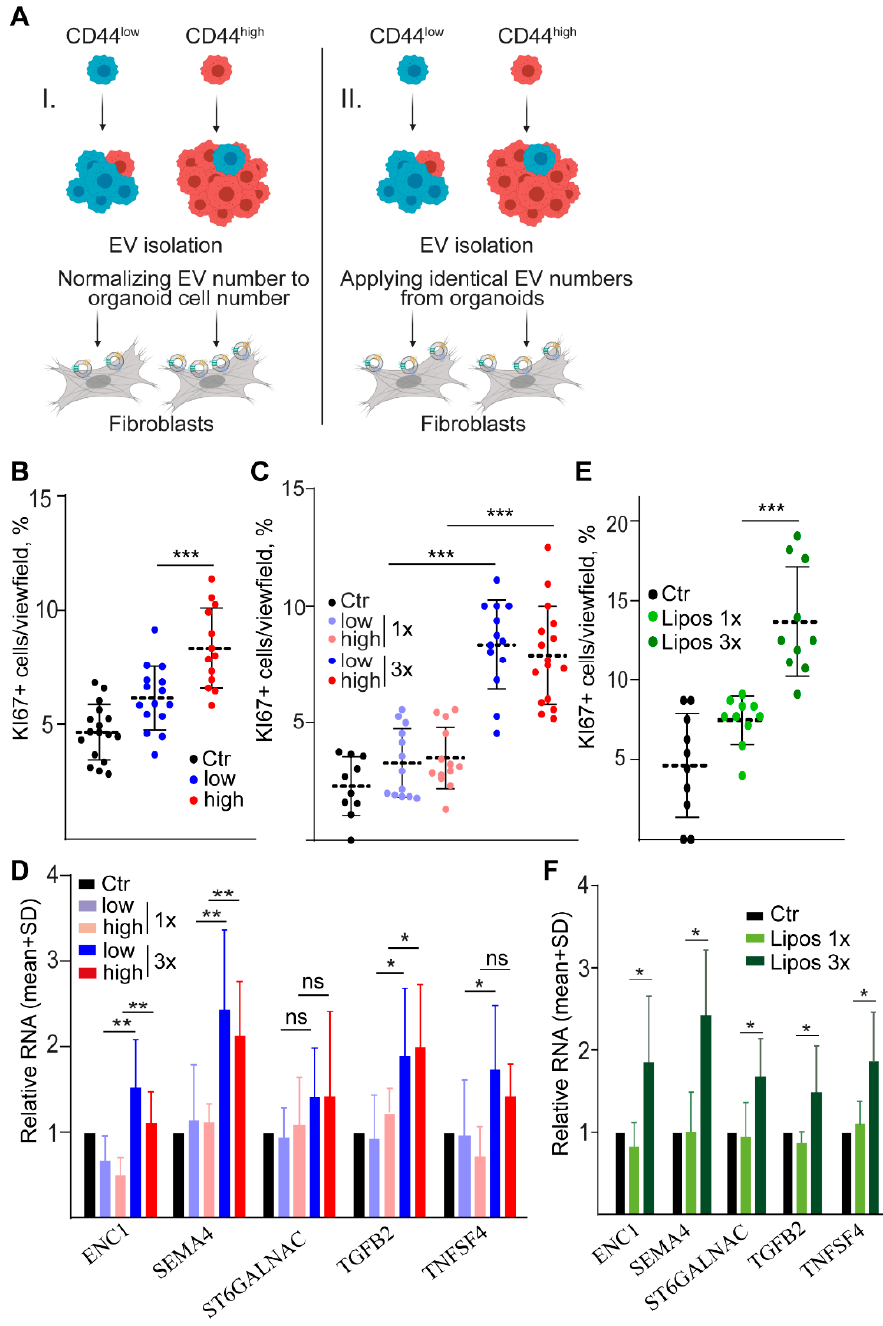
Figure 5. EV effect on fibroblasts depends on the EV dose, but not on the miRNA cargo. ( A ) Schematic representation of the experimental setups. Note that fibroblasts were treated with EVs either from identical cell numbers (left panel, setup I) or with identical EV numbers derived from different CRC subpopulations (right panel, setup II). ( B ) The percentage of KI67+ colon fibroblasts when applying EVs from 10 6 cells. EVs were collected from the supernatants of CD44 high or CD44 low cell-derived organoids on day 7 and fibroblasts were treated for 48h (quantification of confocal microscopic images, experimental setup I). Note that control samples received no EVs. ( C ) The percentage of proliferating fibroblasts when applying increasing numbers of CD44 high or CD44 low organoid-derived EVs (experimental setup II). ( D ) RNA levels for the indicated genes in fibroblasts treated with CD44 high or CD44 low cell-derived EVs at different concentrations (setup II). Data were normalized to